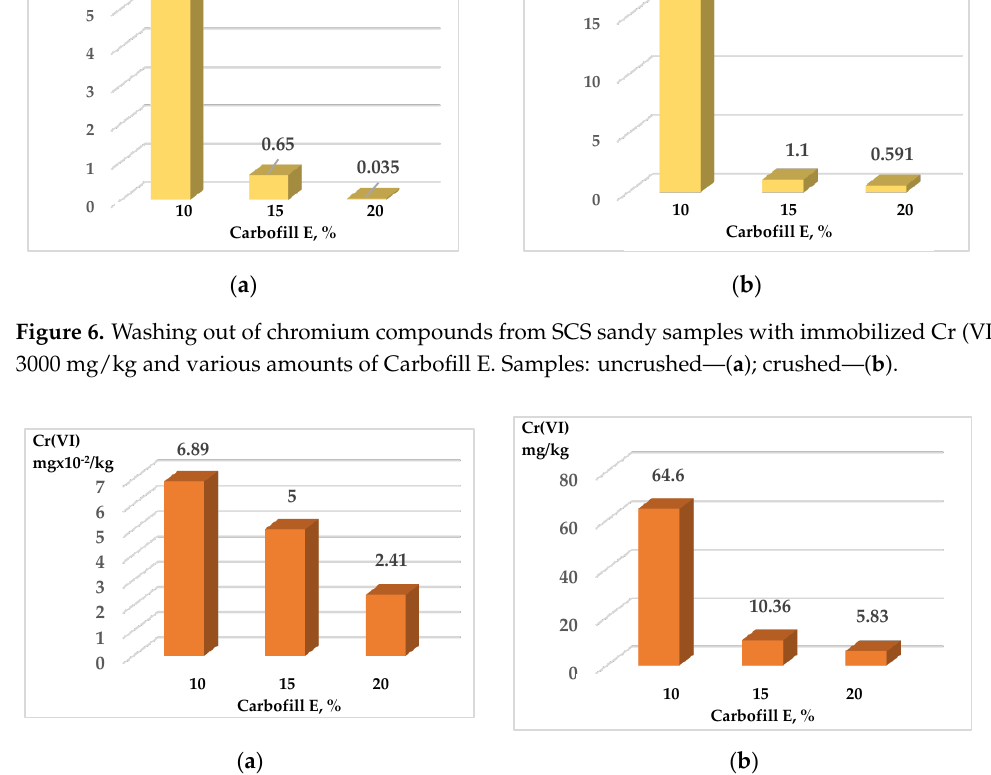
Figure 7. Washing out of chromium compounds from SCS clay samples with immobilized Cr (VI) 3000 mg/kg and various amounts of Carbofill E. Samples: uncrushed—( a ); crushed—( b ). Since 10% Carbofill E in the sandy and clay SCS samples is sufficient to immobilize Cr (VI), further studies were performed on samples with 10% of this binder. The sandy samples of SCS with immobilized Cr (VI) content exceeding the permissible level from 5 to 1000 times have been investigated. As can be seen from the graphs in Figure 8, the maximum chromium content (589.61 mg/kg) was washed out only from the crushed sample, which had a maximum chromium content (10 5 mg/kg) (Figure 8b). Meanwhile, even at such high levels of chromium, only 9.58 mg/kg was washed out from the undisturbed SCS sample.